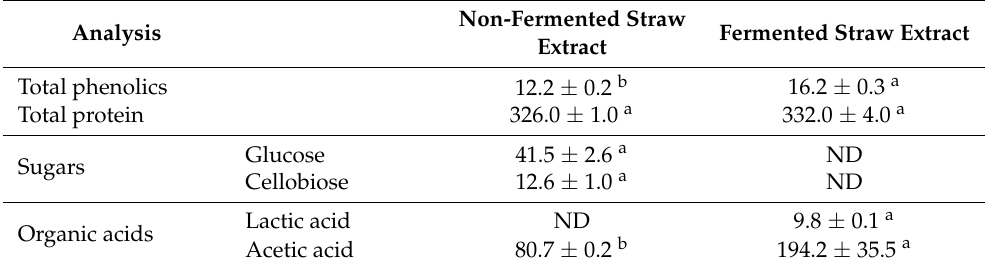
Table 1. Levels of the major biochemical constituents (mg/g DW; means ± SD) in sugarcane straw powder extract before and after S. cerevisiae